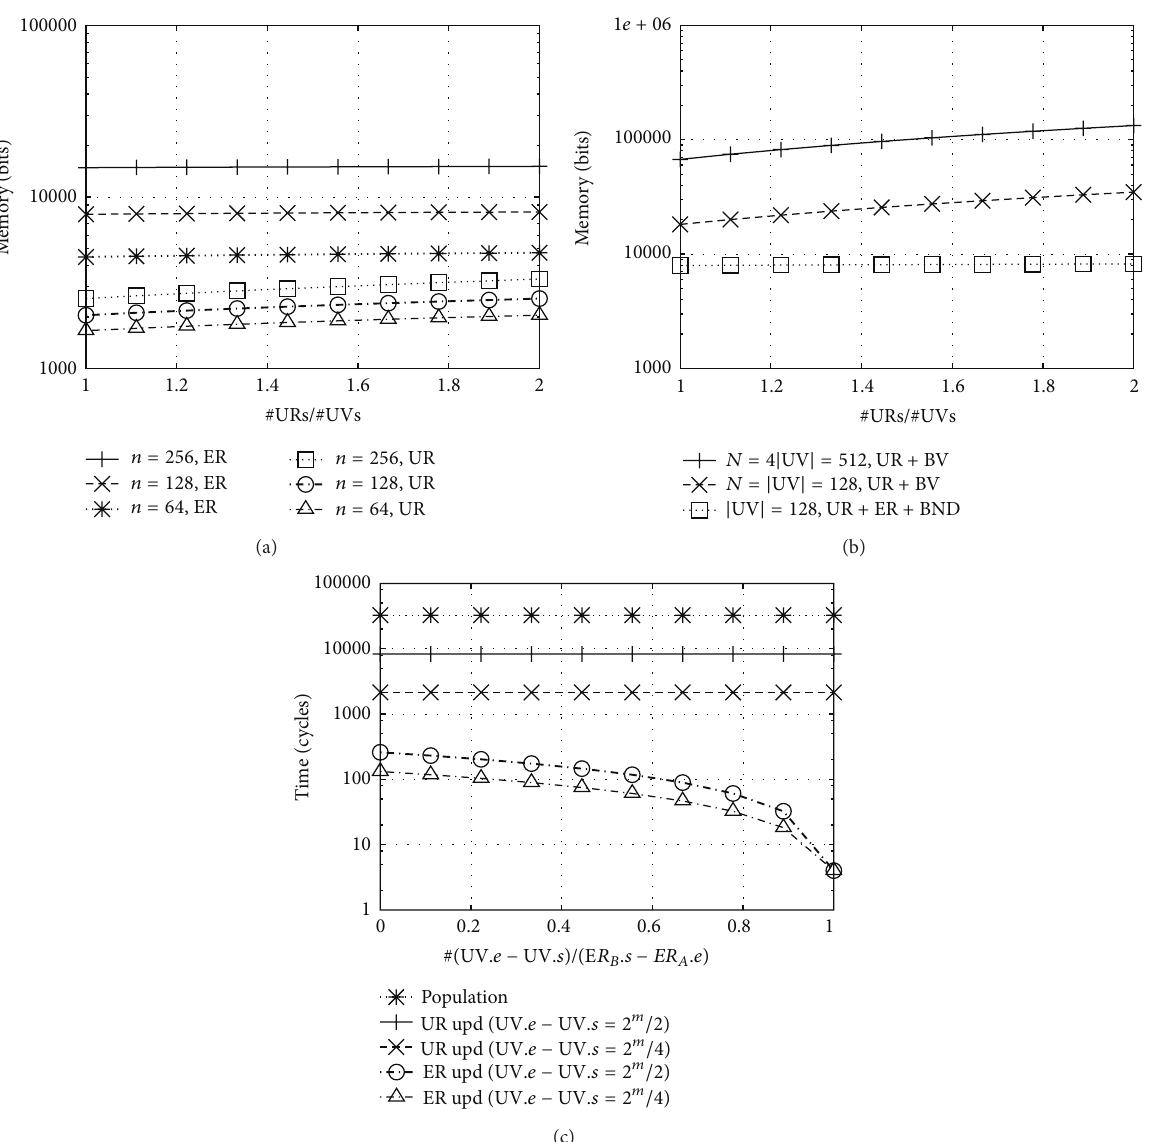
Figure 23: Updating of IND schemes: (a) memory consumption of 𝑢𝑟 𝑚𝑒𝑚 versus 𝑒𝑟 𝑚𝑒𝑚 , (b) total memory consumption, and (c) required clock